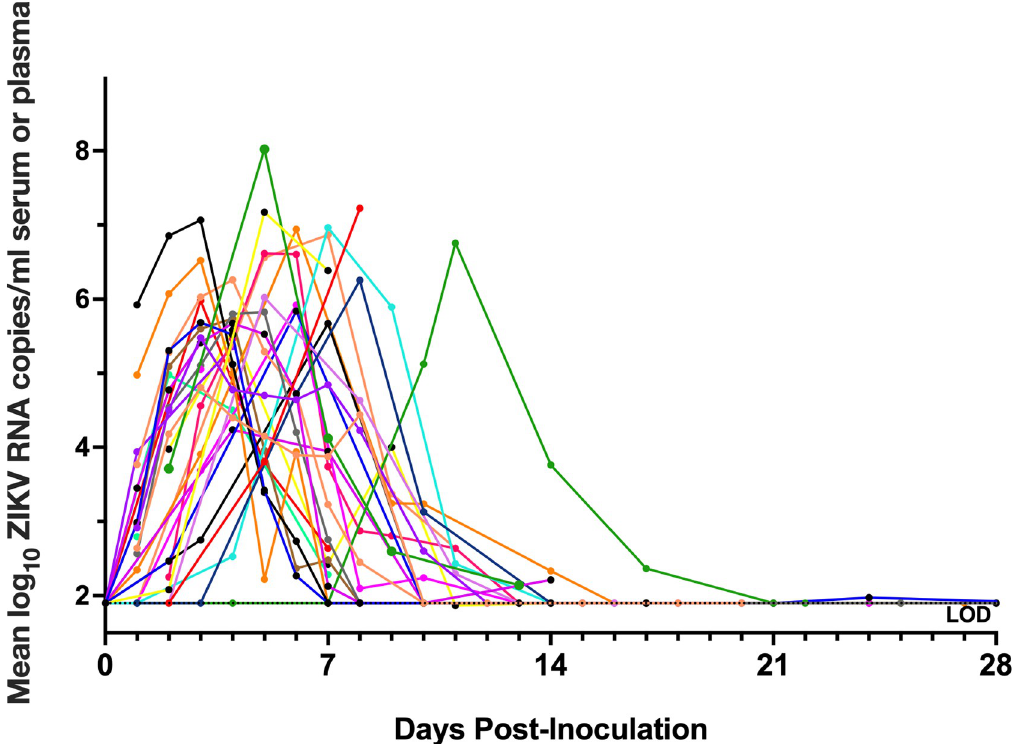
Fig 1. Zika virus viremia in adult male macaques lasts for 4 to 25 days post-inoculation with a peak from 4–8 log 10 RNA copies/mL at 4–5 days post-inoculation (DPI). ZIKV RNA levels in serum or plasma, reported as mean log 10 RNA copies/ml and assayed in triplicate. Each line/symbol represents an individual macaque (N = 36). Viremia data was not available for each of the 51 animals. Rhesus macaques pre-treated with anti-ZIKV antibody were not included in calculations of average viremia duration and magnitude and are not presented on this graph. The dotted line denotes the average limit of detection (LOD), 1.9 log 10 RNA